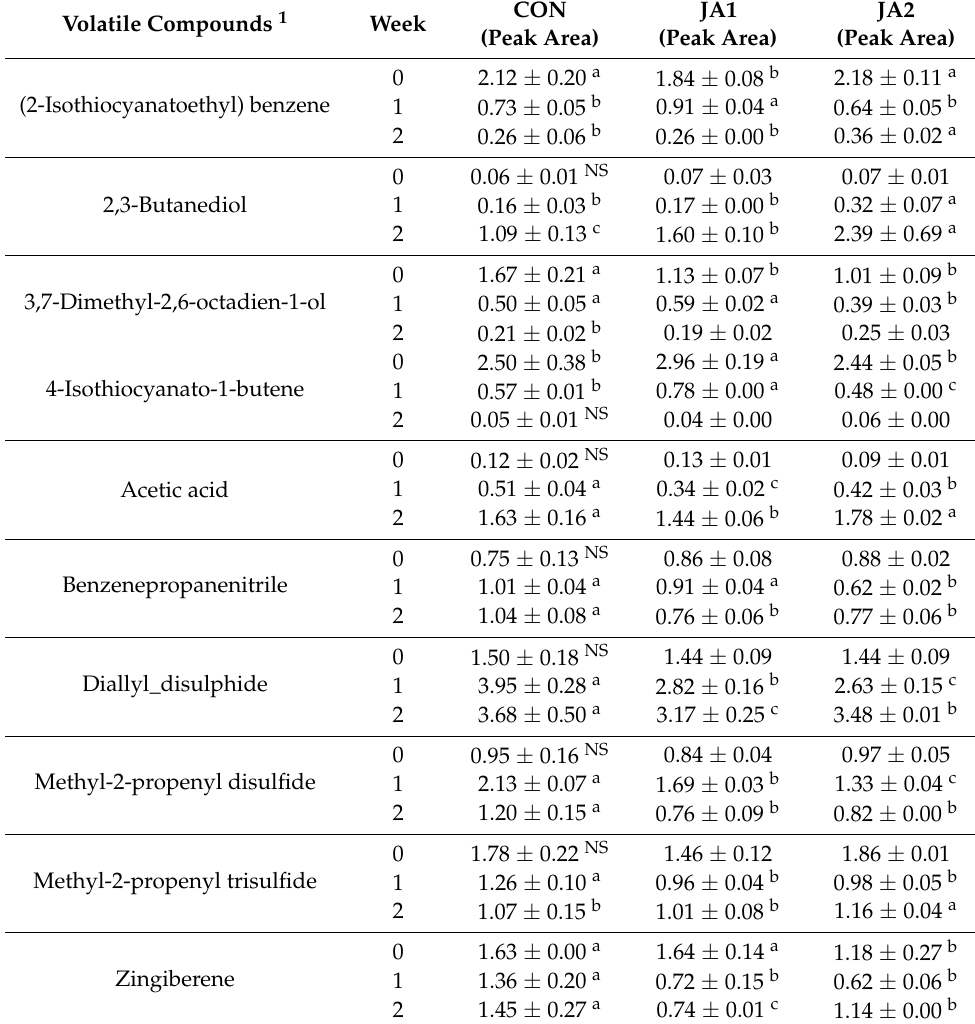
Table 9. Volatile compounds composition in kimchi prepared with jeotgal